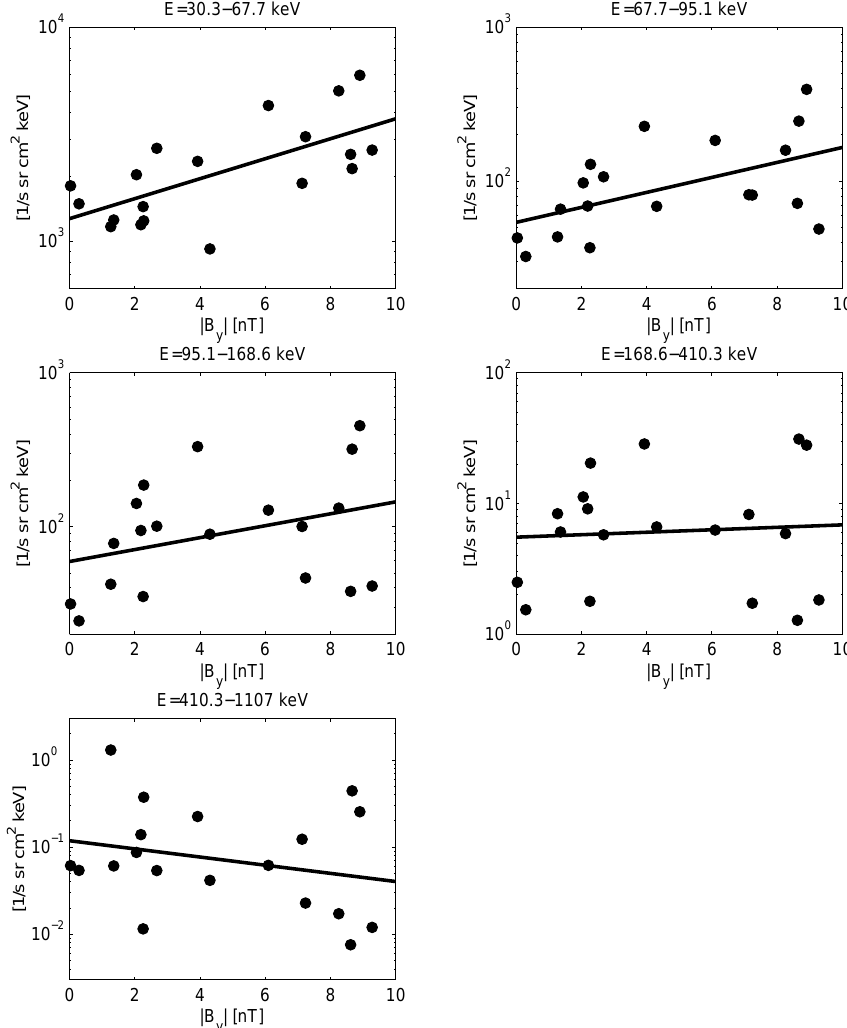
Fig. 4. Differential proton fluxes observed in the exterior cusp at the five lowest energy channels as a function of IMF | B y | .